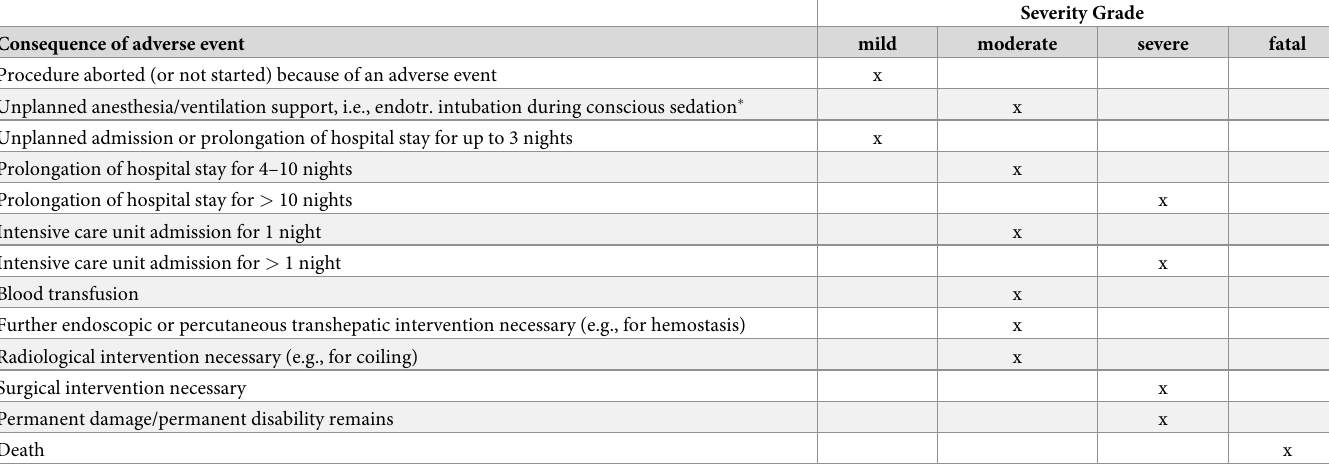
Table 2. Classification of AEs by severity in line with the recommendations of the ASGE workgroup